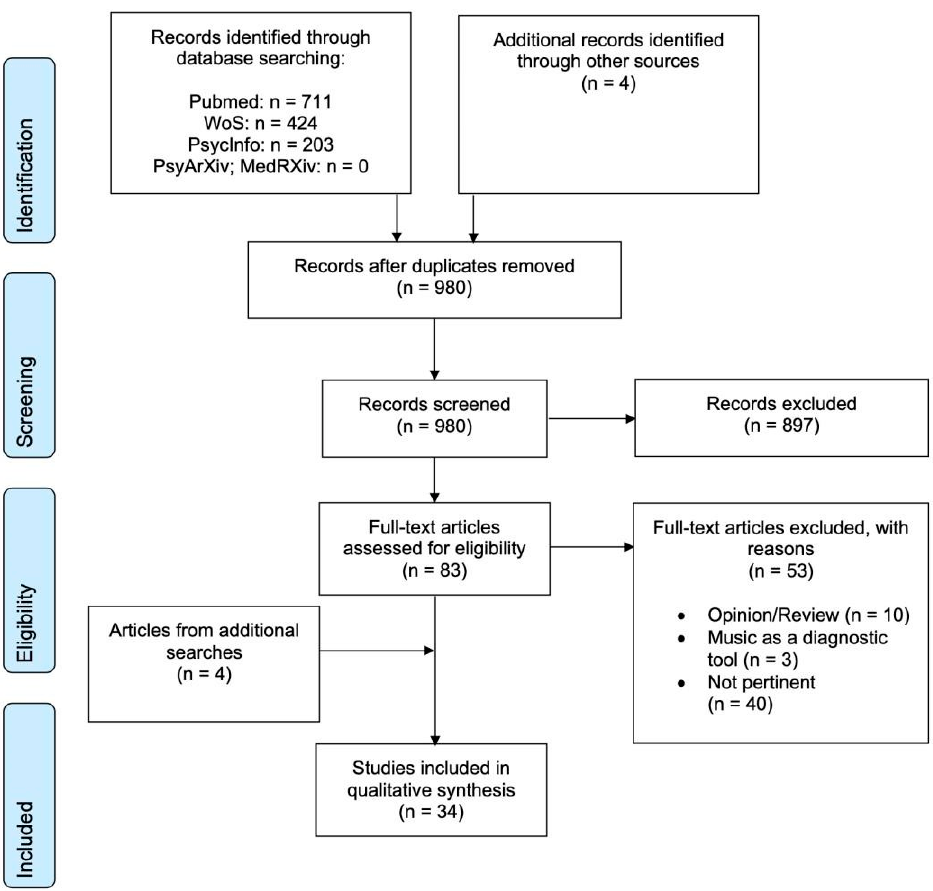
Figure 1. Flowchart of the literature search process.